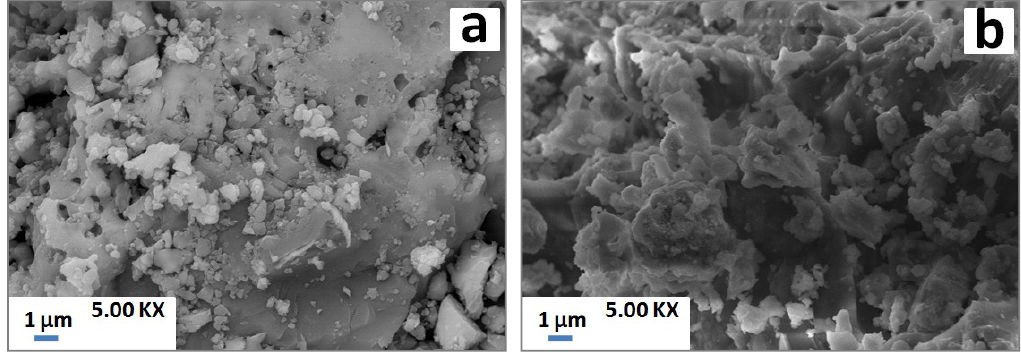
Figure 7. SEM micrographs of PS-SC (20 wt. % of SC) blends heated at 900 °C ( a ) and 1100 °C ( b ).